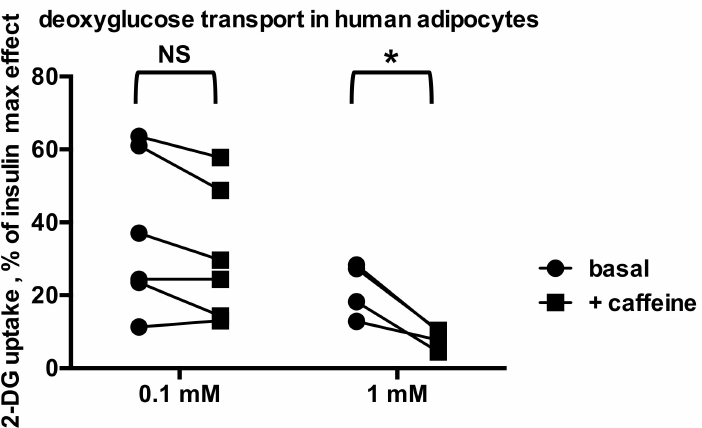
Figure 6. Influence of caffeine on basal hexose transport in human adipocytes. [ 3 H]-2-DG uptake is expressed as percentage of maximal response to 100 nM insulin, set at 100% in each individual. Each couple of points corresponds to an adipocyte preparation from an adult individual, incubated without (basal, circles) or with the indicated dose of caffeine (squares). Difference from corresponding basal by paired t test. NS indicates differences that were not significant (data for six individuals) while * indicates significant inhibition (data for four individuals) at: p <